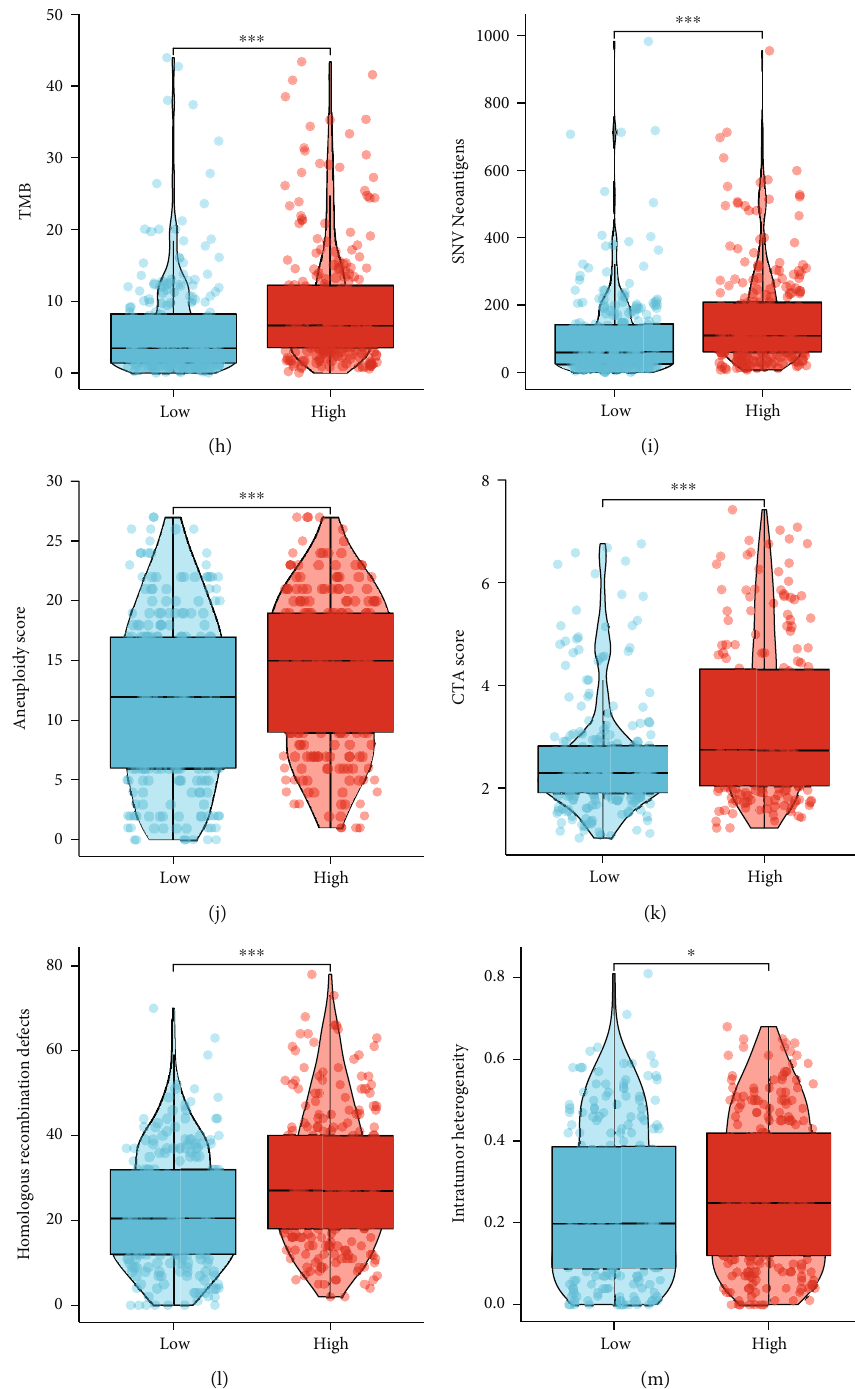
Figure 5: Genomic alteration features of the cuproptosis-relevant lncRNA signature. (a) Waterfall plot illustrating the fi rst 20 mutated genes in high-risk subset. Statistical plots of mutation events for each mutated gene are exhibited in the right panel. Variant classi fi cations are labeled by unique colors. (b) Waterfall plot depicting the fi rst 20 mutated genes in low-risk subset. (c, d) Signi fi cant focal copy-number gains (red) and losses (blue) in high-risk subset. (e, f) Signi fi cant focal copy-number gains and losses in low-risk subset. (g) Distribution of fraction of genome altered, lost, and gained in low- and high-risk subsets. (h – m) Comparison of TMB, SNV neoantigens, aneuploidy score, CTA score, homologous recombination defects, and intratumor heterogeneity between two subsets. ∗ p < 0 : 05 ; ∗∗∗ p < 0 : 001 ; ∗∗∗∗ p < 0 : 0001